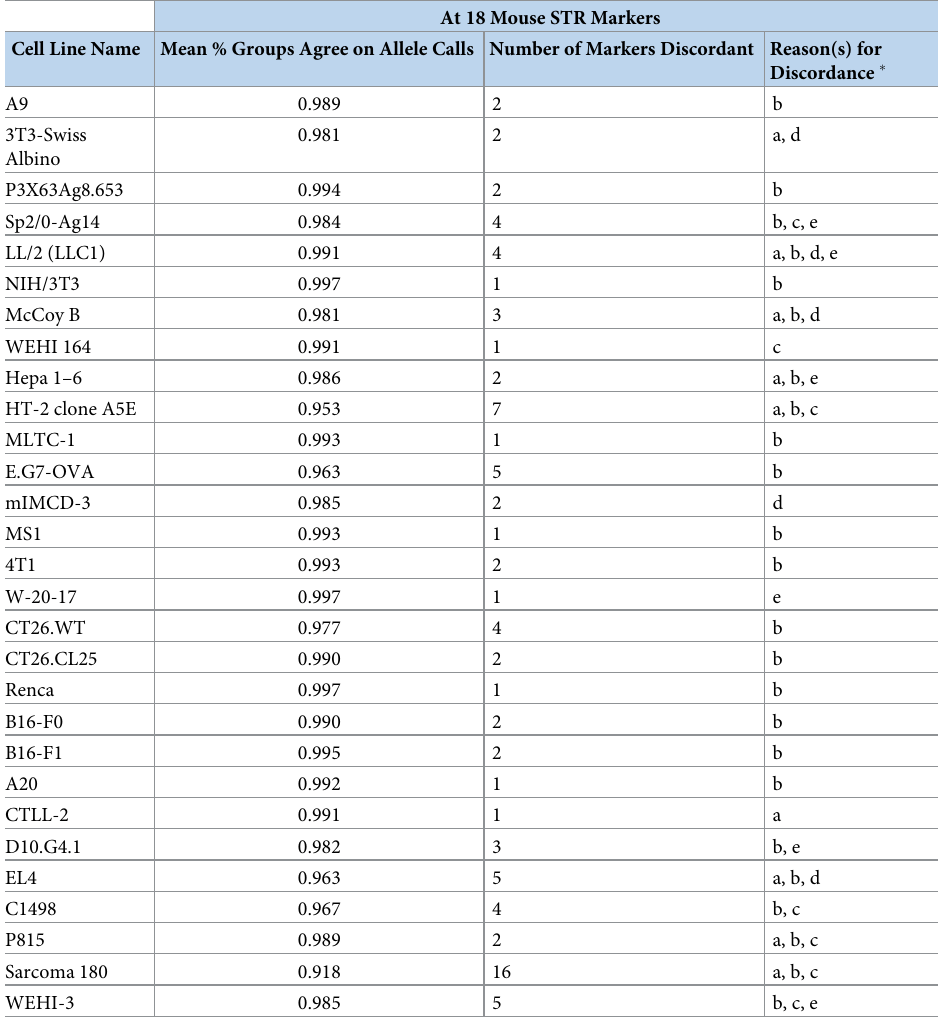
Table 7. Summary of discordant cell line.